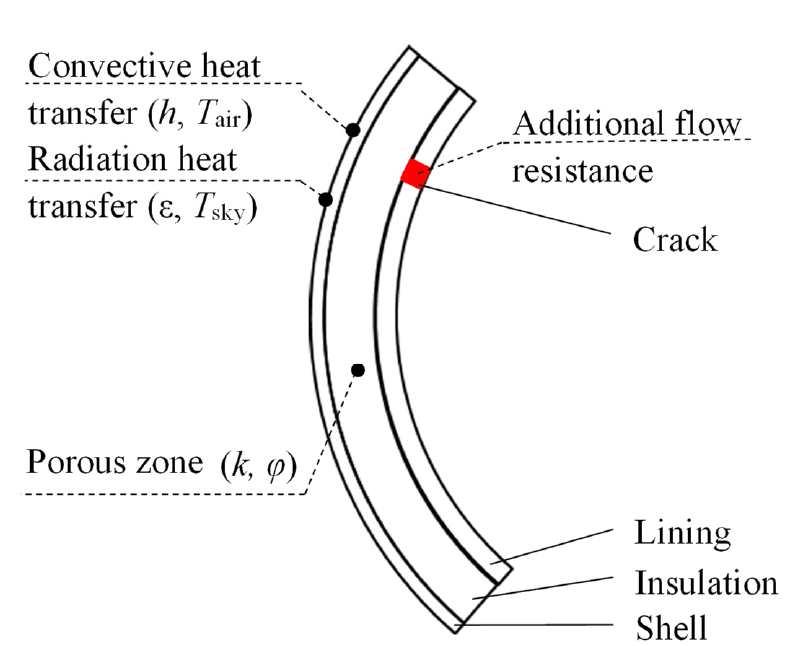
Figure A1. Modeling strategies.